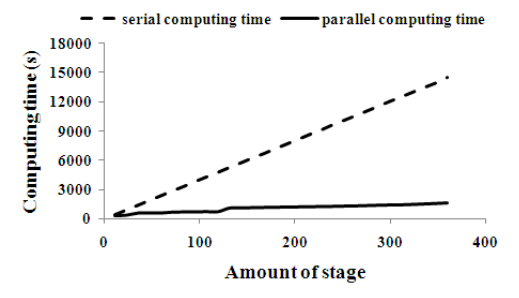
Fig. 6 Comparison of computation time